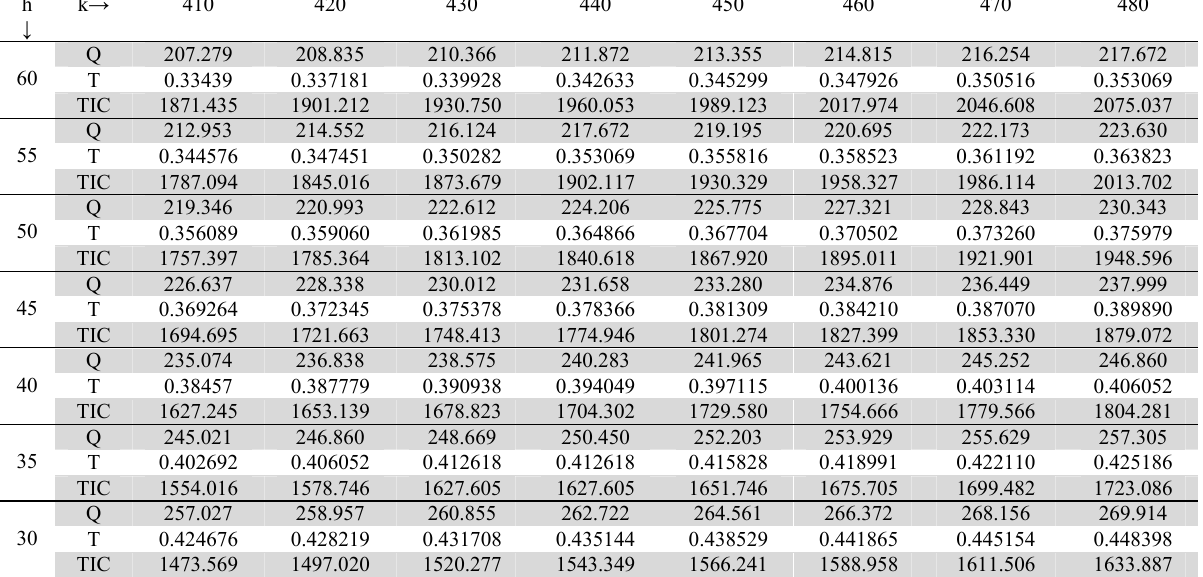
Variation of optimal solution of Q = Q*, T* and TIC* with the variation of ‘h’ and ‘k’, keeping all the parameters same as in Example